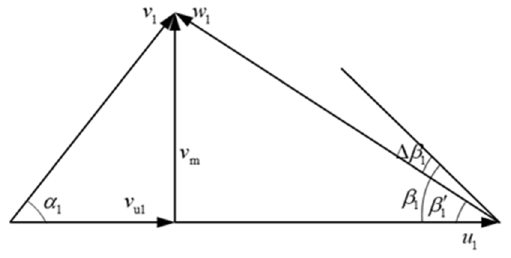
= 10.9 ◦ , β (cid:48) = 14.7 ◦ and β (cid:48) = 19.2 ◦ . The 1a 1b 1c